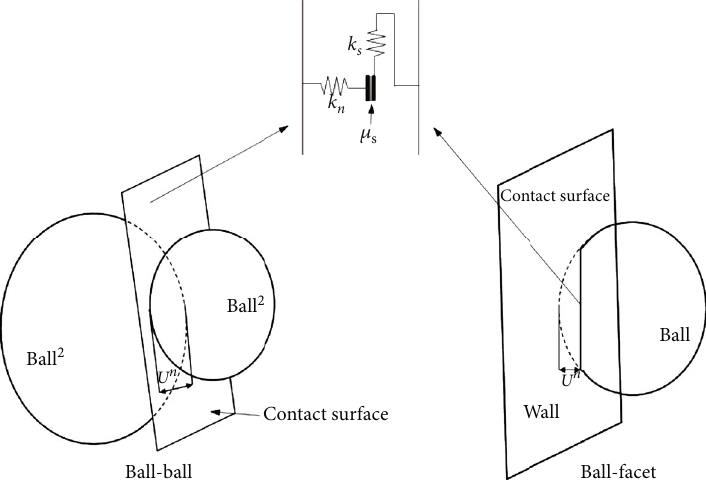
Figure 3: Schematic of substantial contact model in PFC.